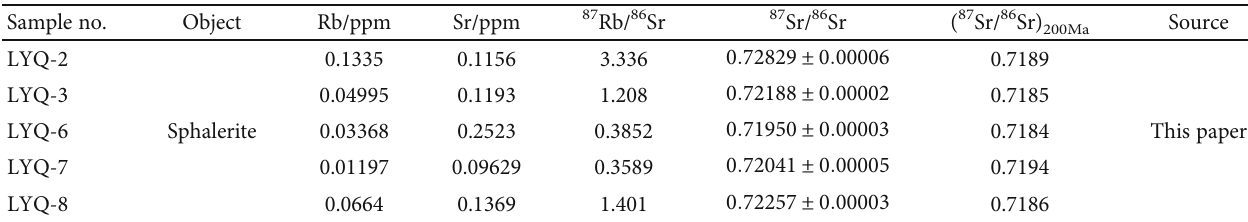
Table 3: Sphalerite Rb – Sr isotopic compositions of the Laoyingqing Pb – Zn deposit. Sample